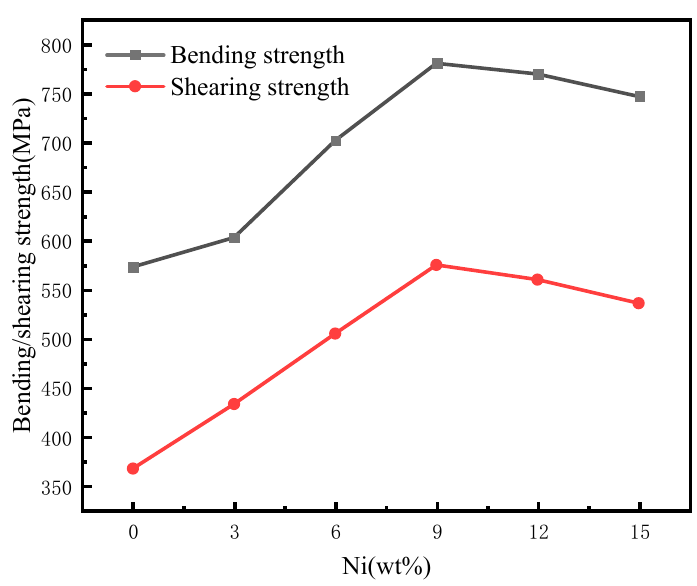
Figure 6. Bending strength and shearing strength of sintered matrix with different Ni contents.